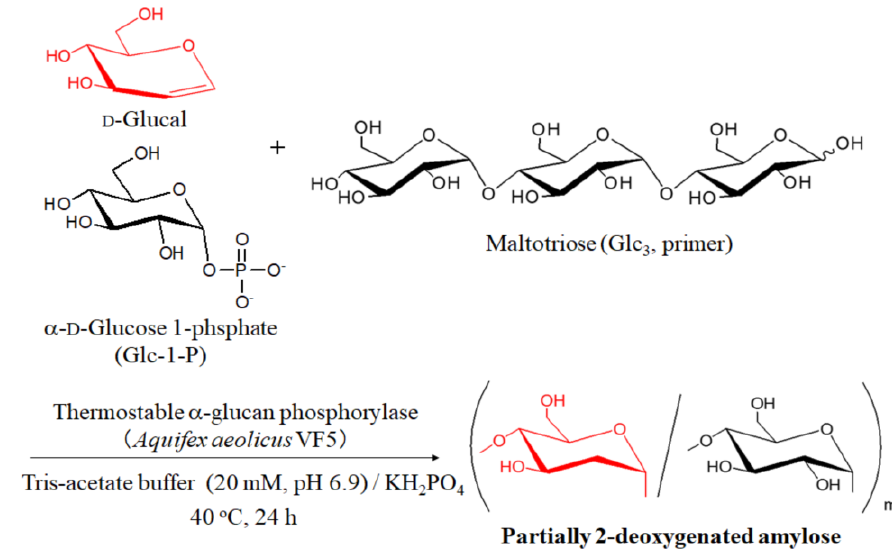
Figure 1. Thermostable α -glucan phosphorylase-catalyzed enzymatic copolymerization of d -glucal with Glc-1-P from Glc 3 to produce partially 2-deoxygenated amyloses; m is the degree of polymerization of the produced polysaccharide, including both dGlc and Glc units.